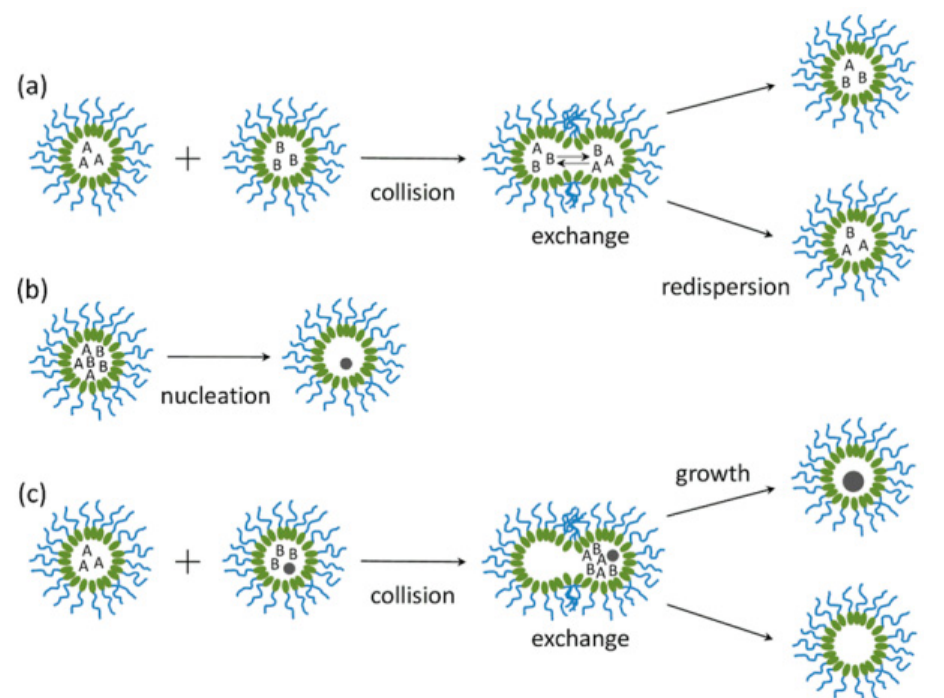
Figure 4. Schematic representation of particle formation in a microemulsion system: ( a ) fusion-fission and mass transfer between microemulsion droplets; ( b ) nucleation in a supersaturated droplet; ( c ) growth of a particle through the exchange of reactants during a collision. Reprinted with permission from ref. [64]. Copyright 2014 American Chemical Society.